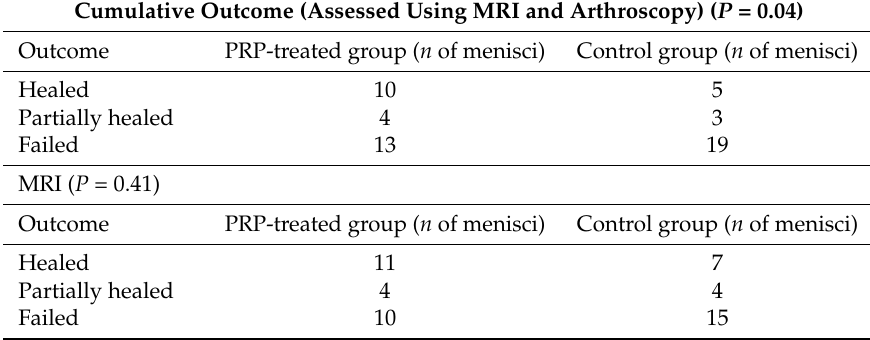
Table 2. Primary outcome assessment.